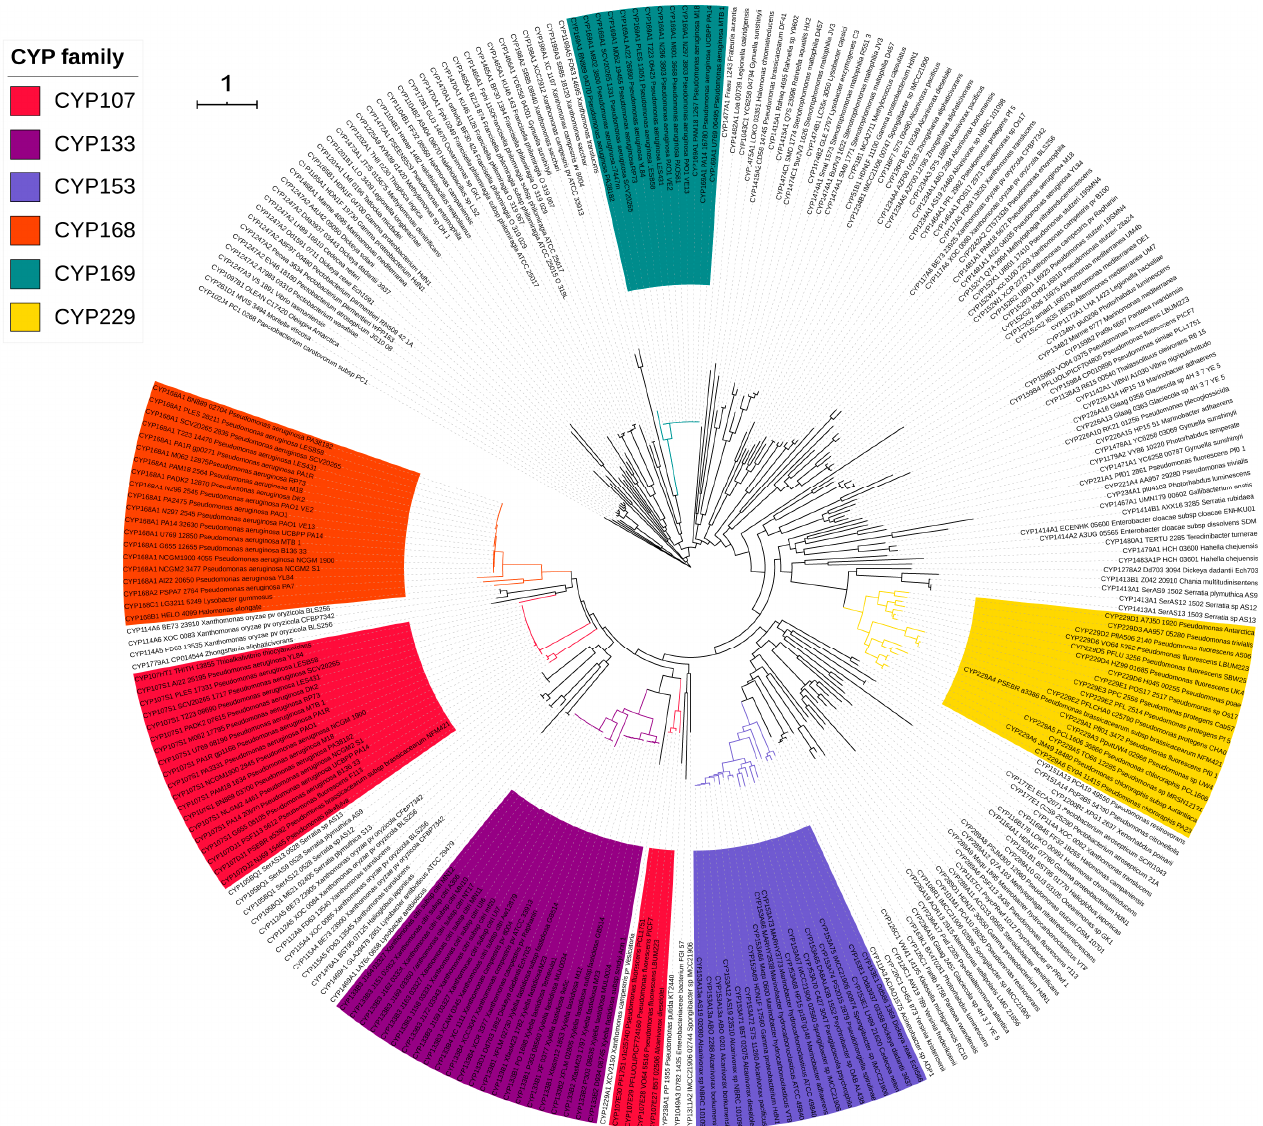
Figure 2. Phylogenetic analysis of Gammaproteobacterial species P450s. P450 families that are expanded in these species were highlighted in different colors and indicated in the figure. Table 3. Comparative analysis of P450 families and subfamilies in Gammaproteobacterial species.